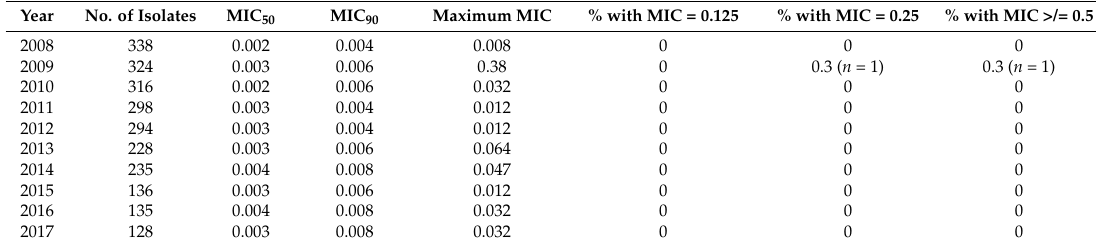
Table 4. Ceftriaxone MIC trend analysis, Johannesburg,